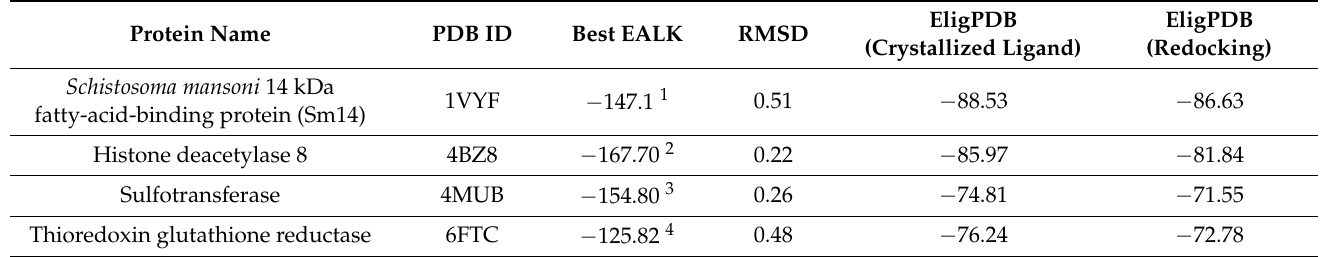
Table 3. Summary of parameters corresponding to the results obtained for all